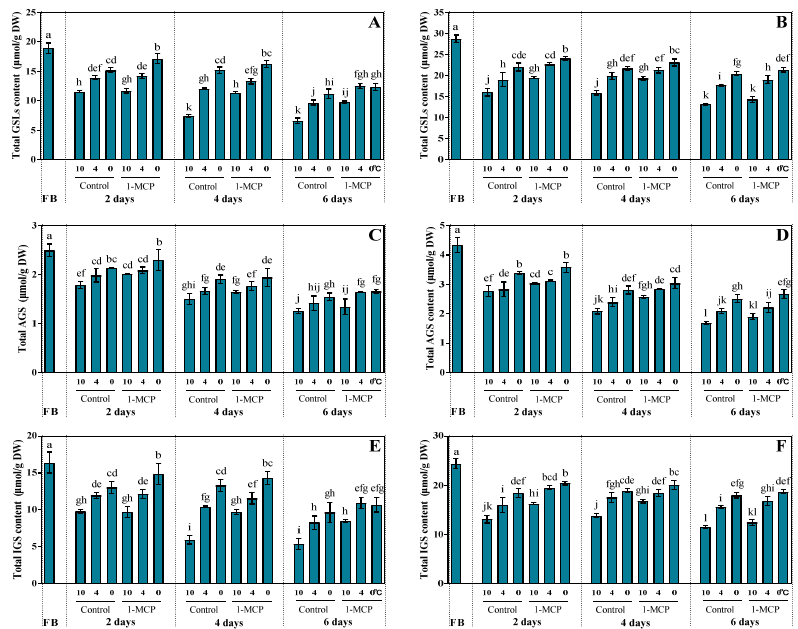
Figure 2. Effects of storage temperature and 1-MCP treatment on GSL content in broccoli florets. Total GSL (( A ): Yanxiu, ( B ): Xianglv No.3), AGS (( C ): Yanxiu, ( D ): Xianglv No.3), IGS content ( E ): Yanxiu, and ( F ): Xianglv No.3). Storage temperature: 10, 4, and 0 ◦ C; control: without 1-MCP treatment; 1-MCP: 1-MCP treatment; FB: fresh broccoli florets; storage time: 2, 4, and 6 days. Error bars represent SD from three replications of under every treatment under storage experiment. Different letters indicate statistically significant differences among treatments ( p < 0.05).